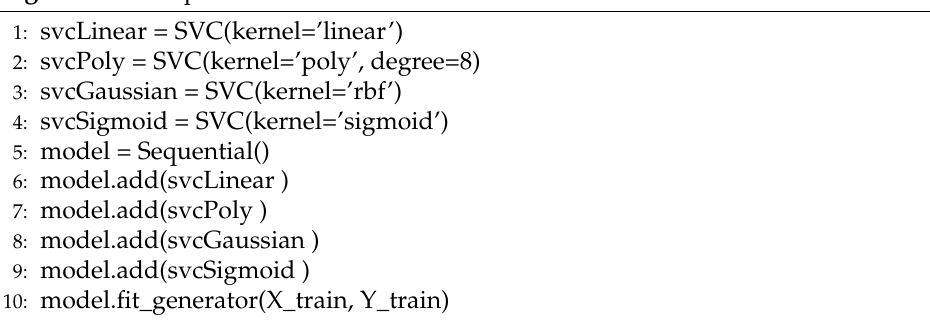
Algorithm 1 for implementation of the proposed approach: Algorithm 1 Deep